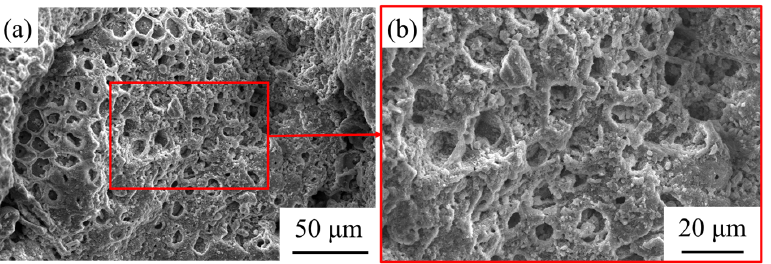
Figure 7. The SEM of the SS-treated coral aggregate: ( a ) morphology under low magnification and ( b ) an enlarged view of the red box area in ( a ).